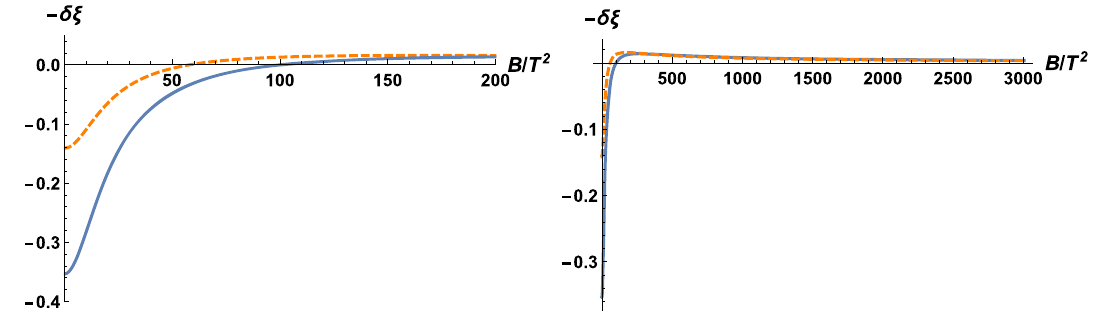
Fig. 5 The anomalous correction δξ as a function of B / T 2 : α = 1 / 20 ,λ = 1 / 50 for the dashed curve and α = 1 / 20 ,λ = 1 / 20 for the solid one